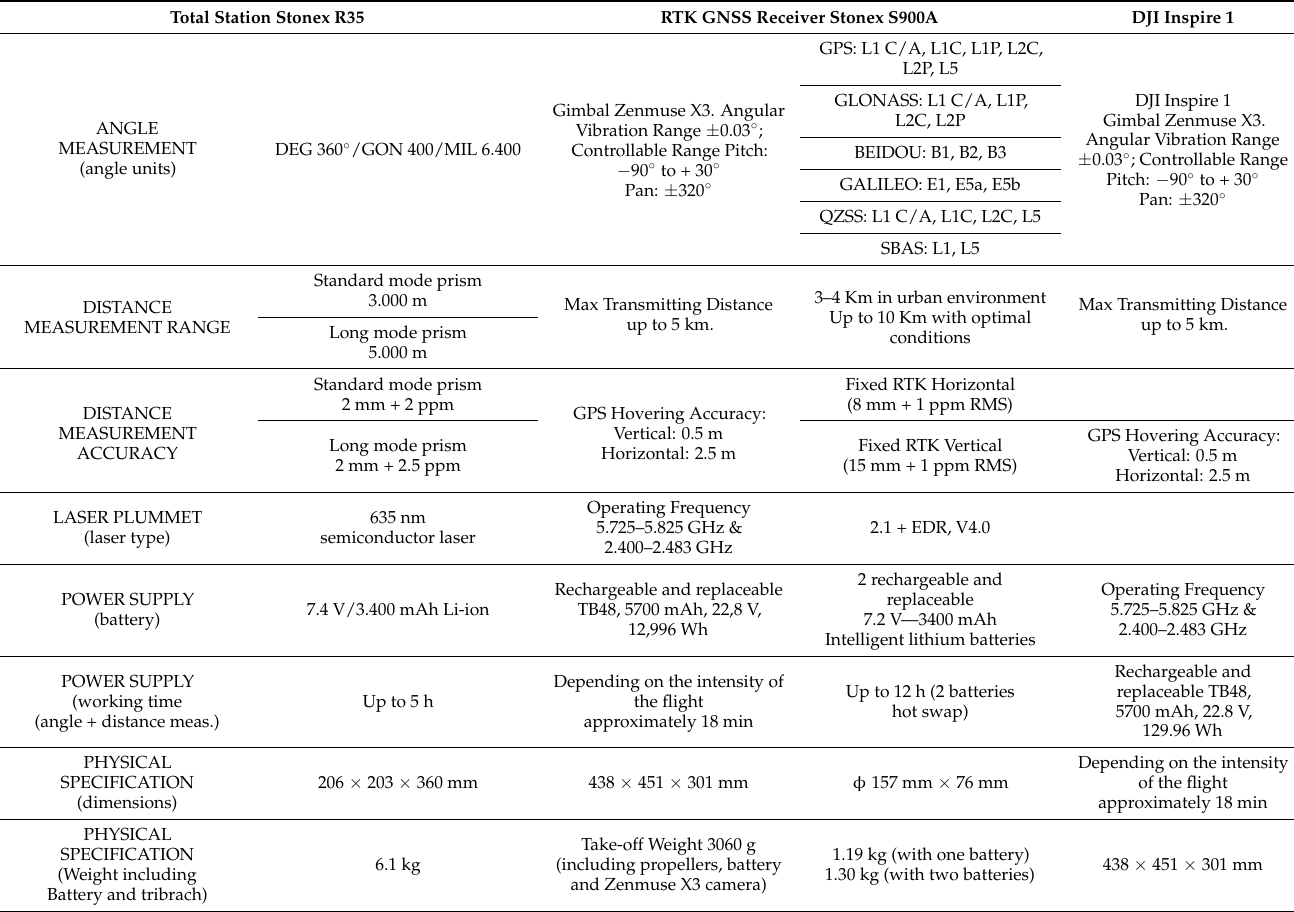
Table 1. Technical specification of the used equipment.